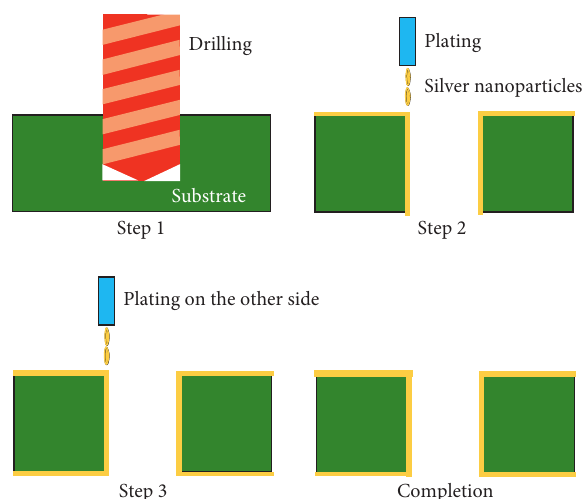
Figure 1: Fabrication process of the fully inkjet-printed via hole.